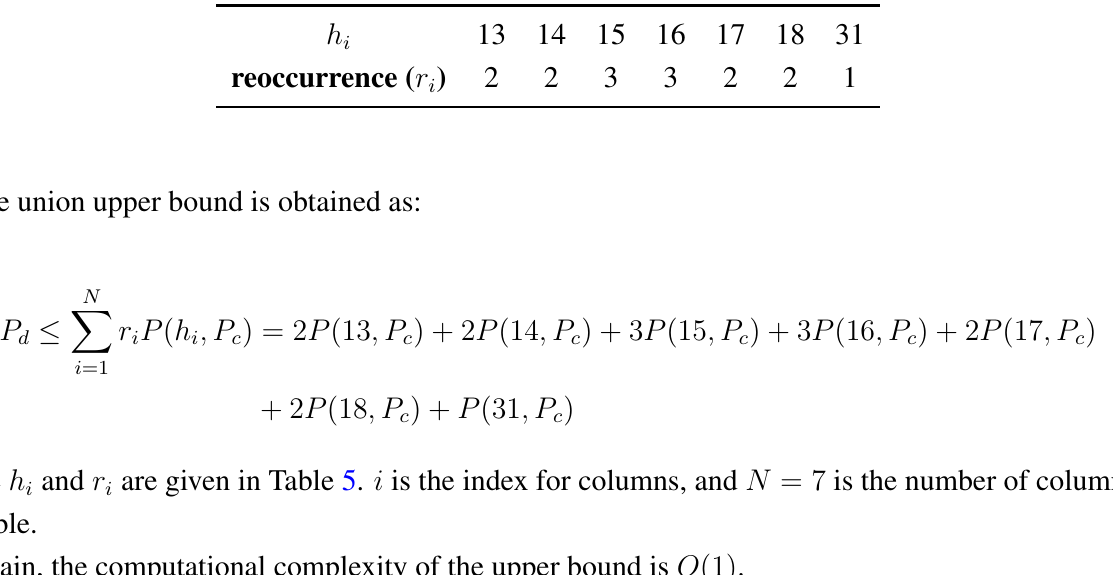
Table 5. Recurrences of unique Hamming distance